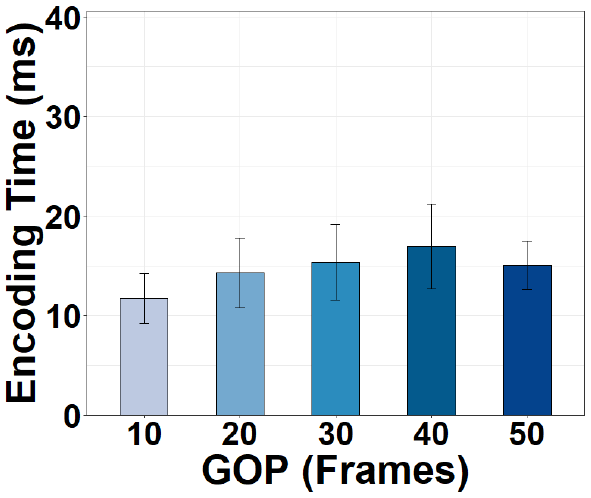
Figure 9. Encoding time of a 720p frame versus